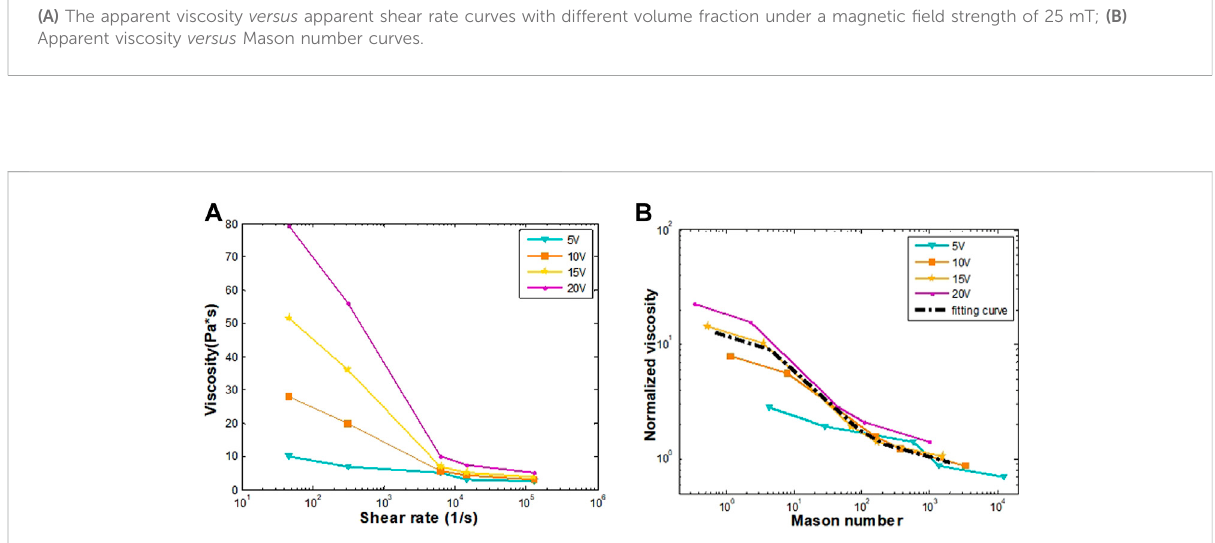
FIGURE 13 (A) Theapparentviscosity versus apparentshearratecurveswithdifferentmagnetic fi eldintensitiesfor20%volumefractionMRFs; (B) Apparent viscosity versus Mason number